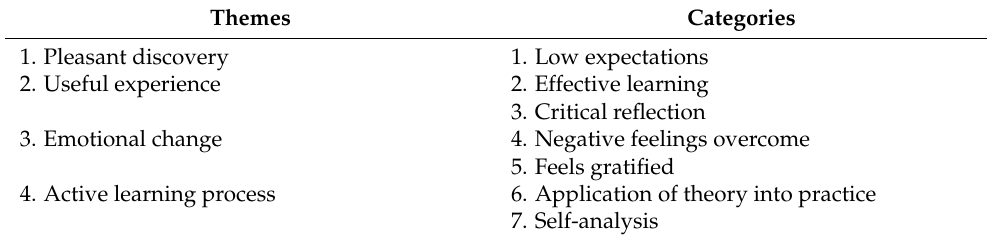
Table 2. Thematic analysis